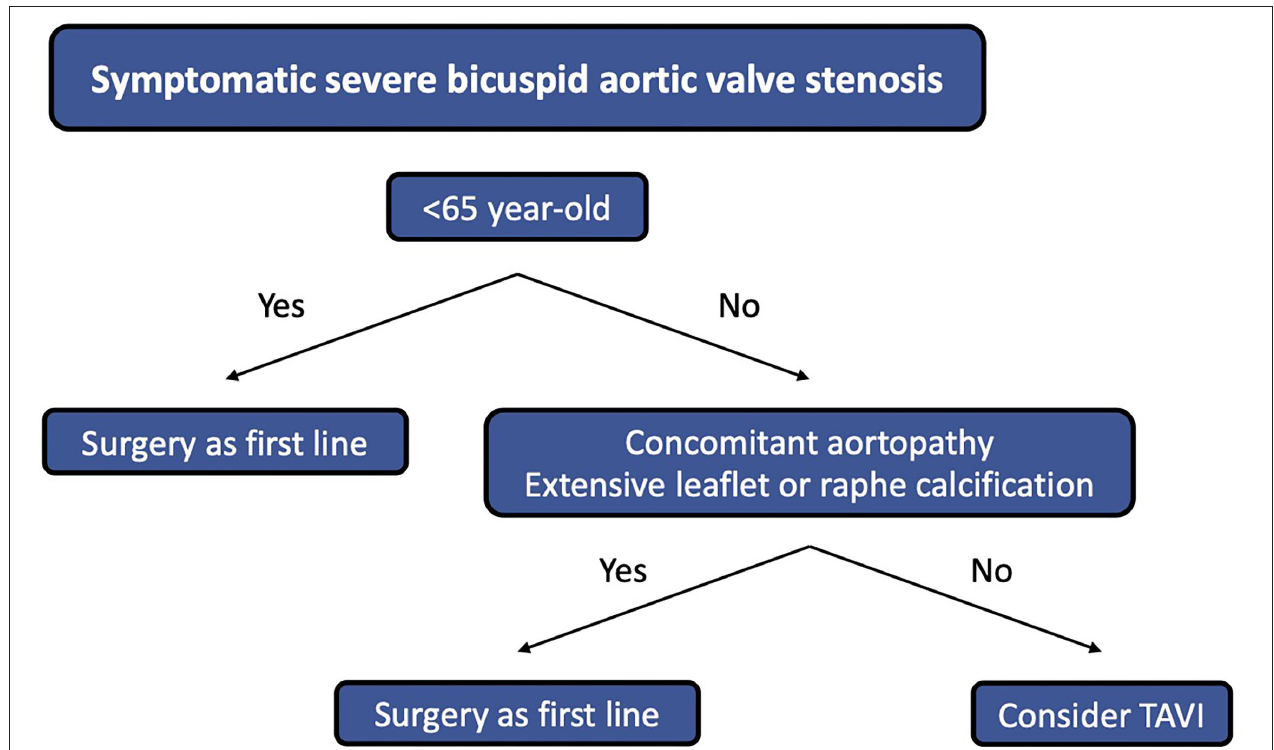
FIGURE 4 | Treatment algorithm of patients with symptomatic severe BAV stenosis.